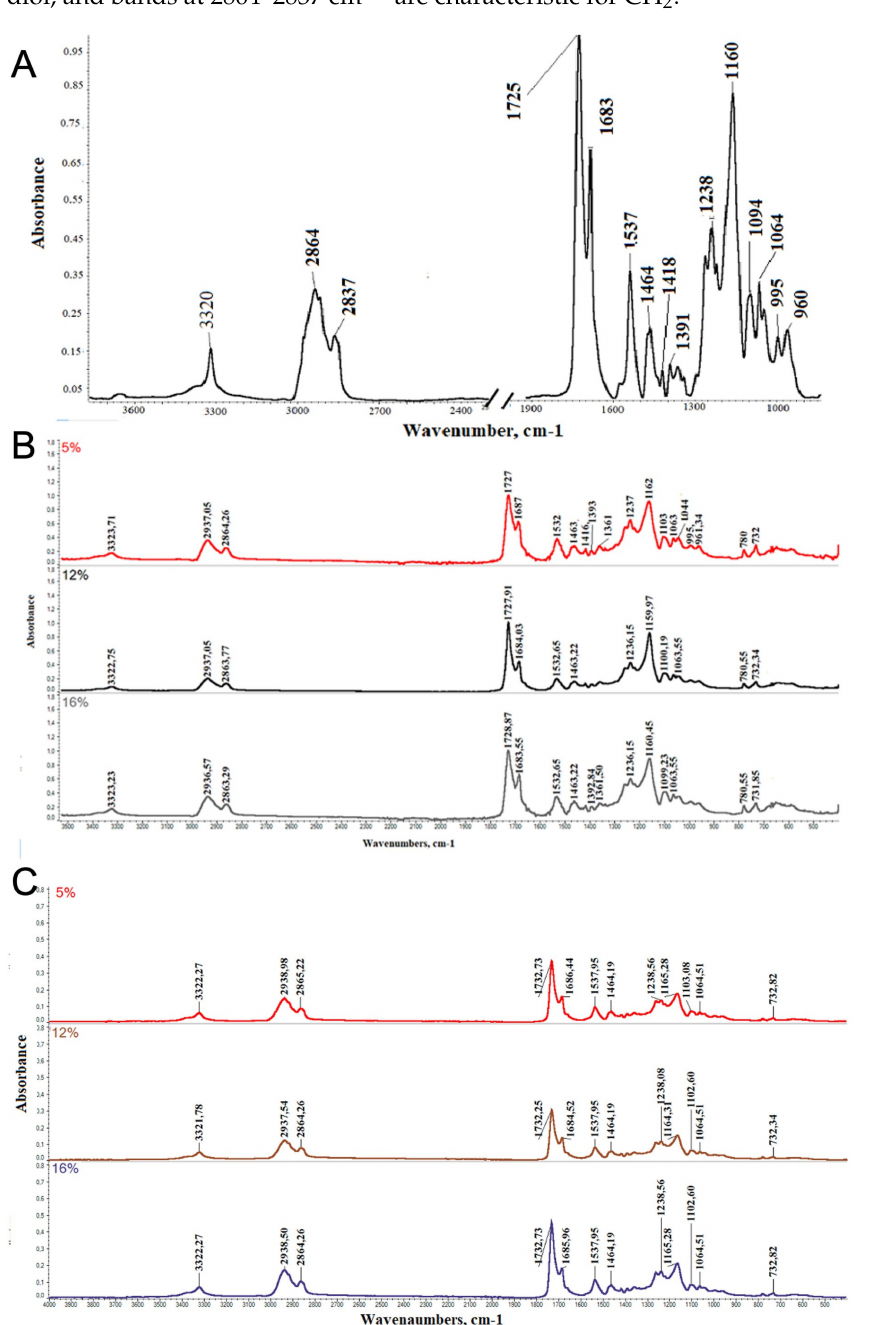
Figure 4. FTIR spectra of ( A ) pristine PU based on a mixture of PCL diols, ( B ) aligned mats PU and ( C ) random PU